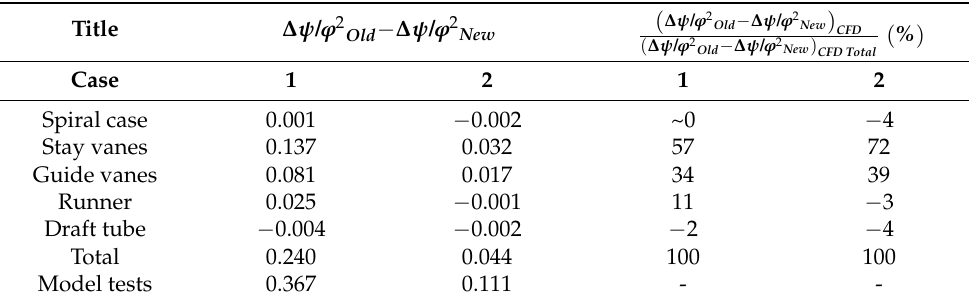
Table 7. Efficiency losses coefficient reduction evaluate by complete turbine simulation. Model tests values are show as